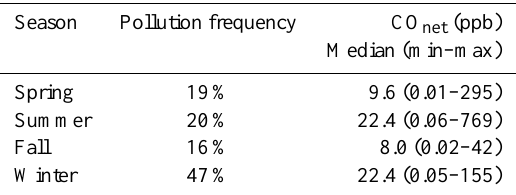
Table 2. Enhancement of CO estimated from REBS baseline (CO net = CO-CO baseline , rebs ) and σ ap to CO net ratios (only for CO polluted episodes) for the 50m height level as derived from hourly average values from October 2006 to December